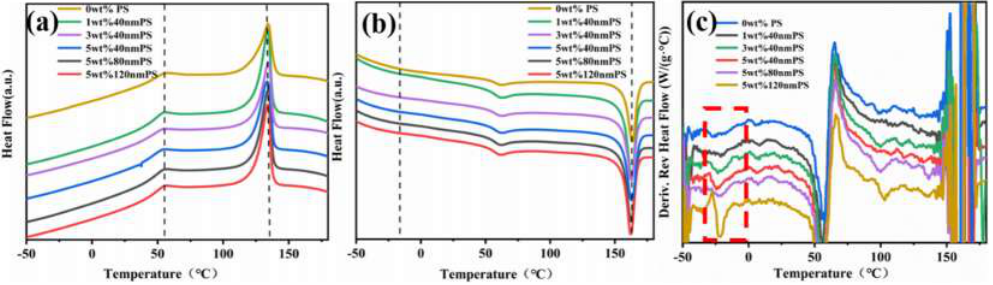
Table 1. The value of T g of various mass fraction of the composite films.